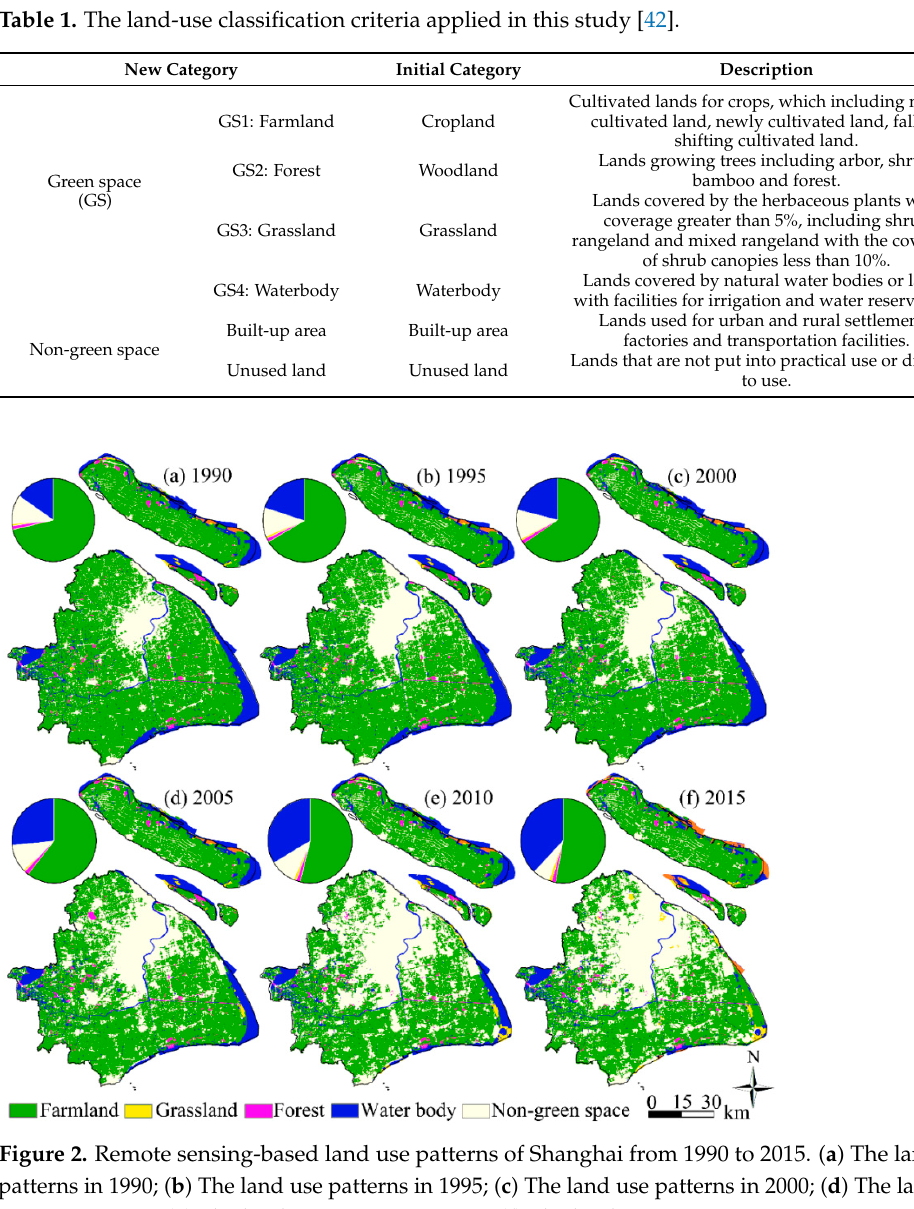
Table 1. The land-use classification criteria applied in this study [42].